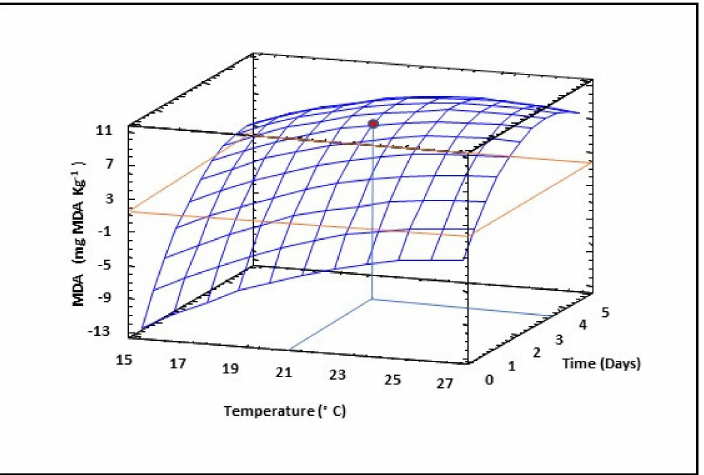
Figure 3. Three-dimensional response surface plots for the content of total malondialdehyde (MDA) as a function of the interaction between germination temperature and time. The red line corresponds with the control (ungerminated seed) and the red point with the value for optimum conditions (21 ◦ C and 3.5